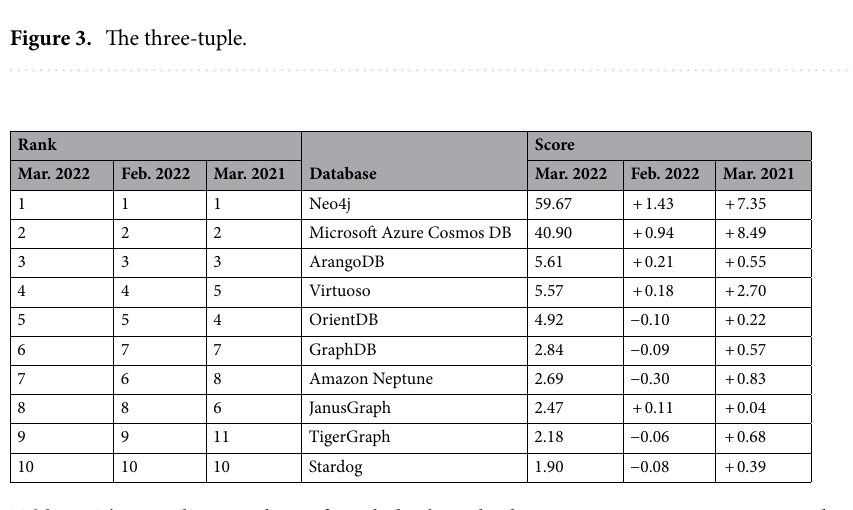
Table 1. The popularity ranking of graph database database management systems in March